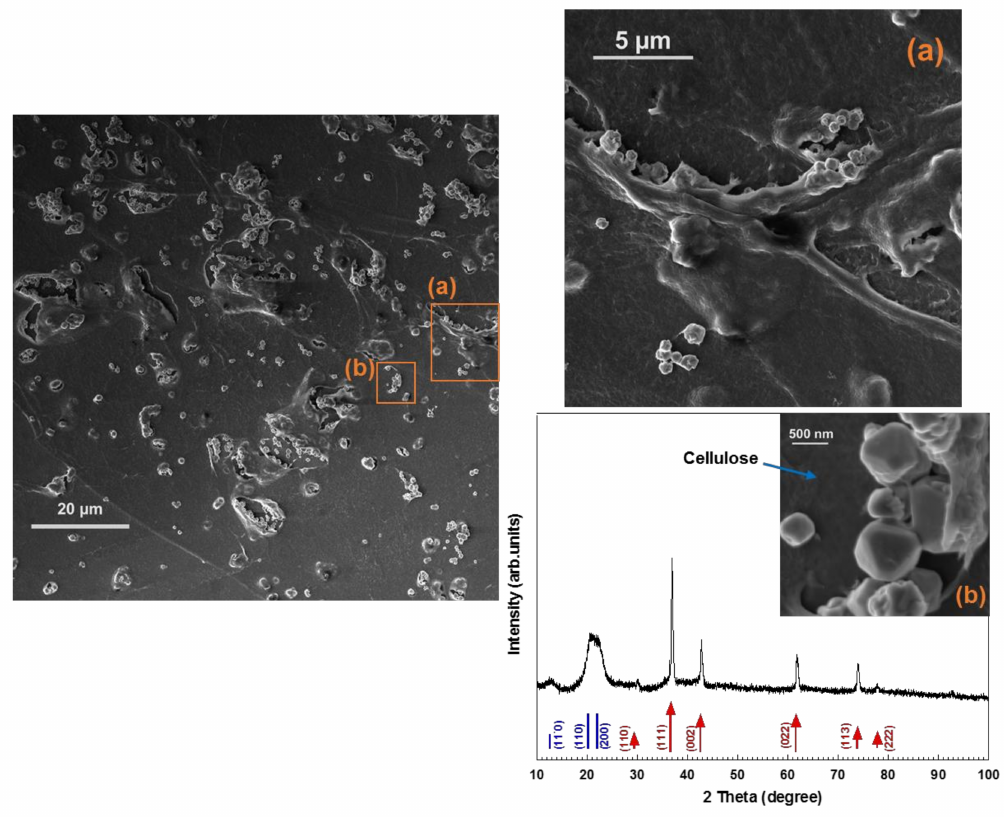
Figure 5. HR-SEM images and XRD pattern of hybrid material produced by spin-coating technique with cellulose solution containing octahedral Cu 2 O NPs (see Figures 3d and 4d). The positions of the expected Bragg peaks from cellulose II (blue lines), and cuprous oxide (red arrows) are marked and labeled with their respective Miller indices. The images (a) and (b) on the right-hand side are high magnification HR-SEM images correspond to the rectangles (a) and (b) in the left-hand side